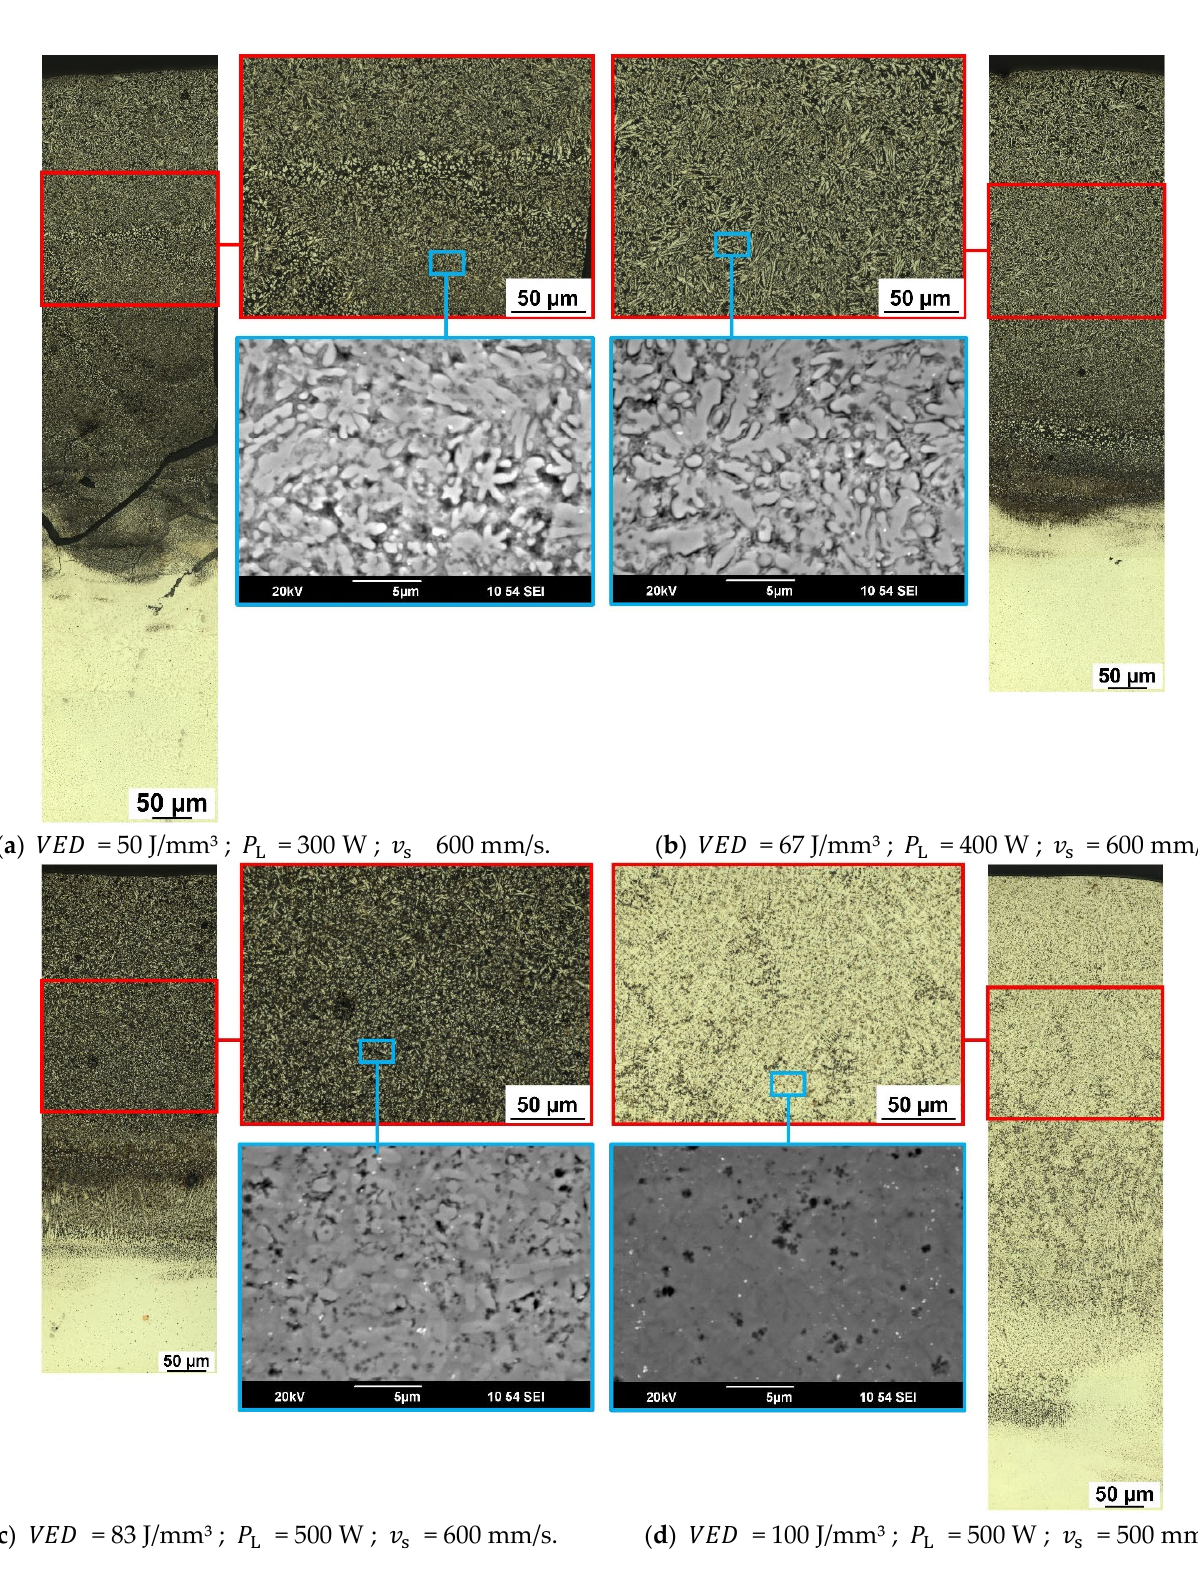
Figure 8. Detailed microstructural analyses, including stitched micrographs from the substrate plate to the top layer, the steady-state region (marked in red), and high-resolution SEM images (marked in blue) of: ( a ) MPEA_50, ( b ) MPEA_67, ( c ) MPEA_83, ( d ) MPEA_100.